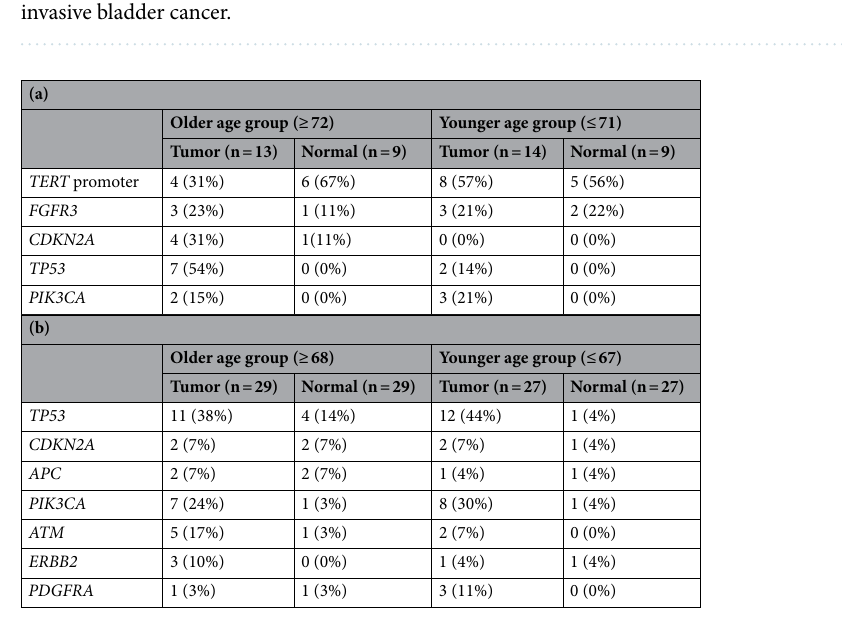
Table 2. The number of mutations of patients with NMIBC by age subgroup (a) and The number of mutations of patients with MIBC by age subgroup (b).